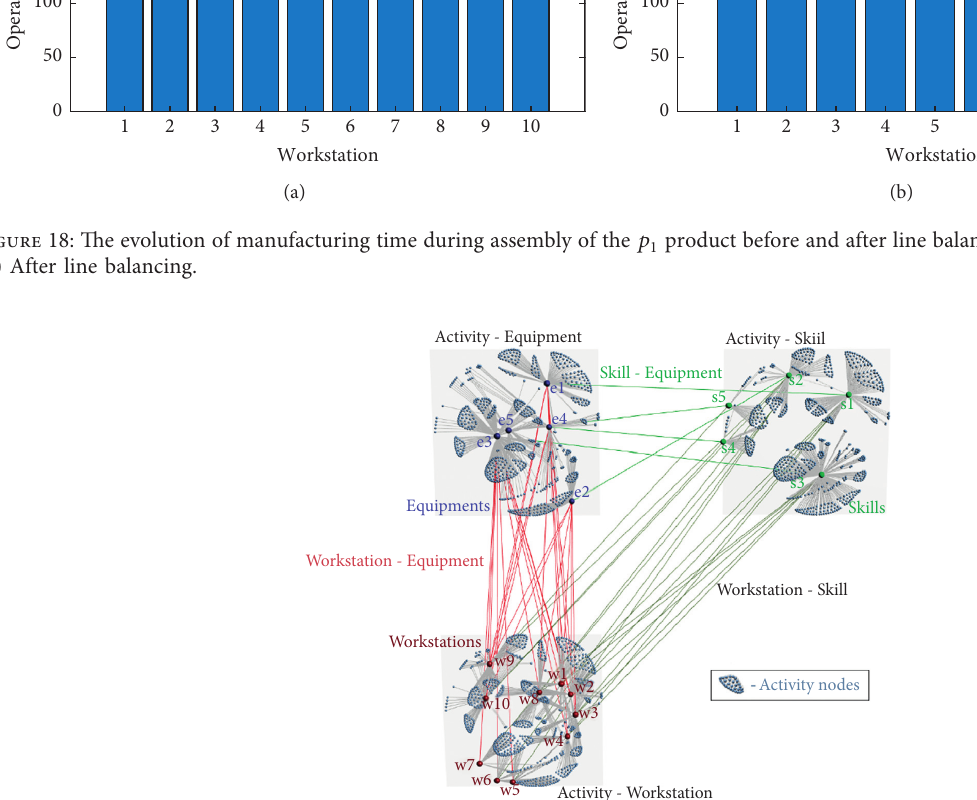
Figure 19: Multilayer visualisation of wire harness manufacturing